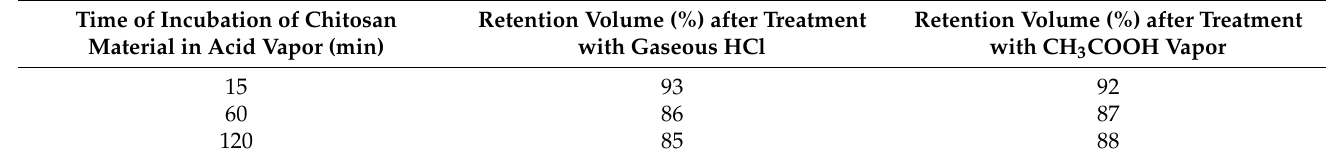
Table 1. The retention volume of modified chitosan nonwovens modified by acid fumes (gass ing process).